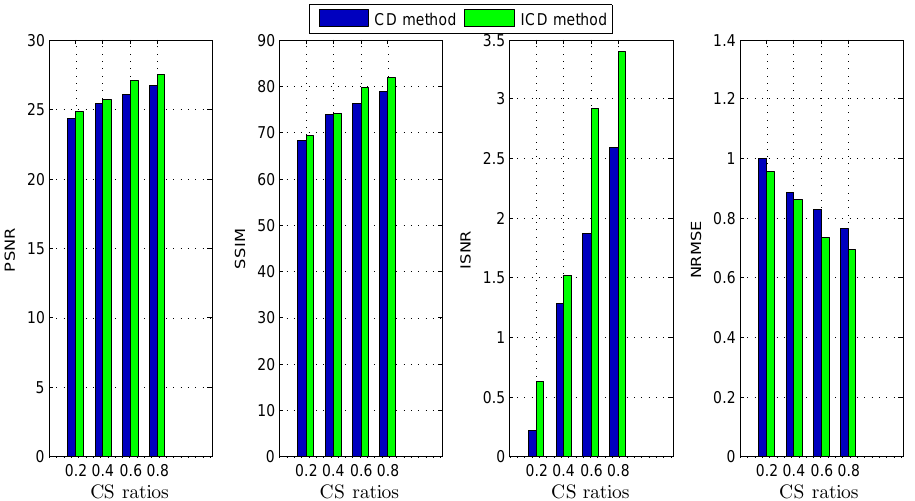
Figure 5. Deconvolution quality assessment for group1 .